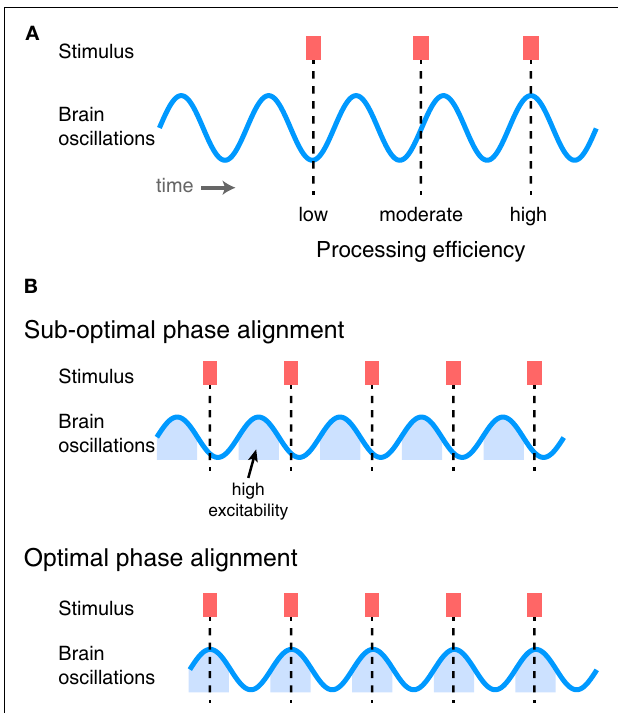
FIGURE 4 | (A) Ongoing oscillatory activity determines how efficiently sensory stimuli drive perceptual processes, depending on the phase of oscillation at which they arrive. Information arriving at a low-excitability phase is processed relatively less efficiently, whereas that arriving at a high-excitability phase is processed more efficiently. (B) If sensory information exhibits temporal regularity, overall processing efficiency can be increased by shifting the phase of ongoing neural oscillations to line up with the phase of the stimuli.Top: Repeated stimuli arriving at sub-optimal phases of neural oscillations. Bottom: By shifting the phase of the brain oscillations, stimuli now arrive at a phase during which neurons are in a relatively excitable state and are thus processed more efficiently (i.e., lead to greater numbers of informative